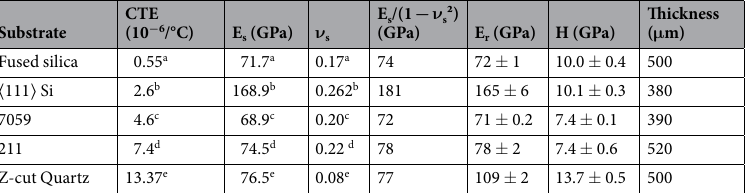
Table 2. Properties of fused silica, 〈 111 〉 silicon, 7059 Corning glass, 211 Precision glass, and Z-cut quartz substrates: coefficient of thermal expansion (CTE), Young’s modulus (E s ), Poisson’s ratio ( ν s ), E s /(1 − ν s2